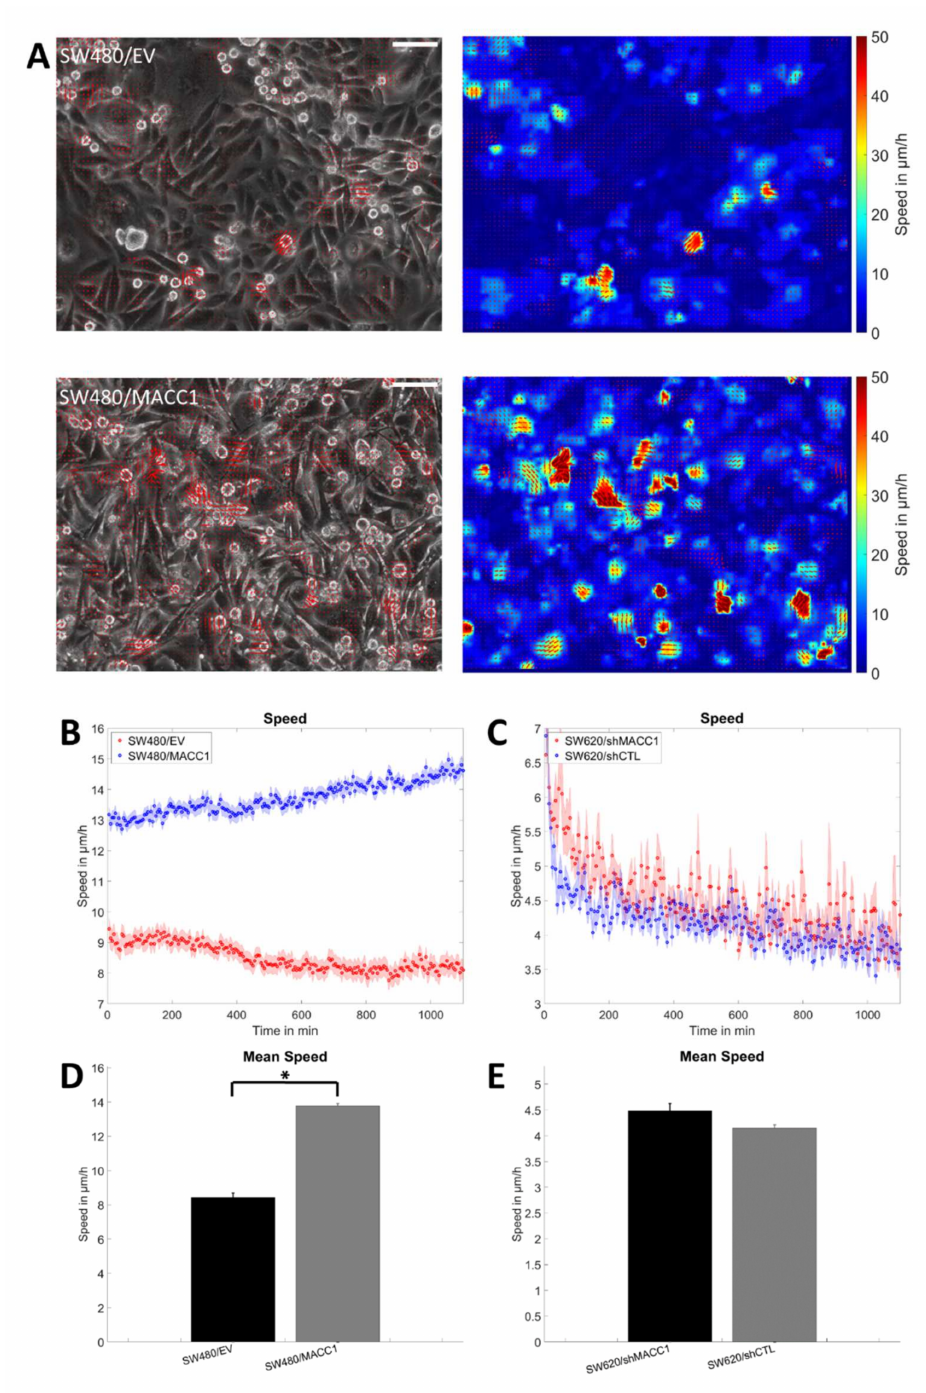
Figure 2. Collective migration of SW480 and SW620 cells. ( A ) The left column shows a typical phase contrast image of SW480, overlaid with the vectors of the velocity fields, and the right column shows the magnitude of the velocity and its direction. The scale bar depicts 50 µ m. ( B , C ) Graph of the mean speeds of SW480 and SW620 cells, respectively. ( D , E ) Mean of the movement speeds of SW480 and SW620 cells from data in ( B , C ). Sample sizes: n SW480/EV = 75; n SW480/MACC1 = 75; n SW620/shMACC1 = 32; n SW620/shCTL = 32. Asterisk depicts statistically significant results with p < 0.05. Error bars and shaded areas depict the standard error of the